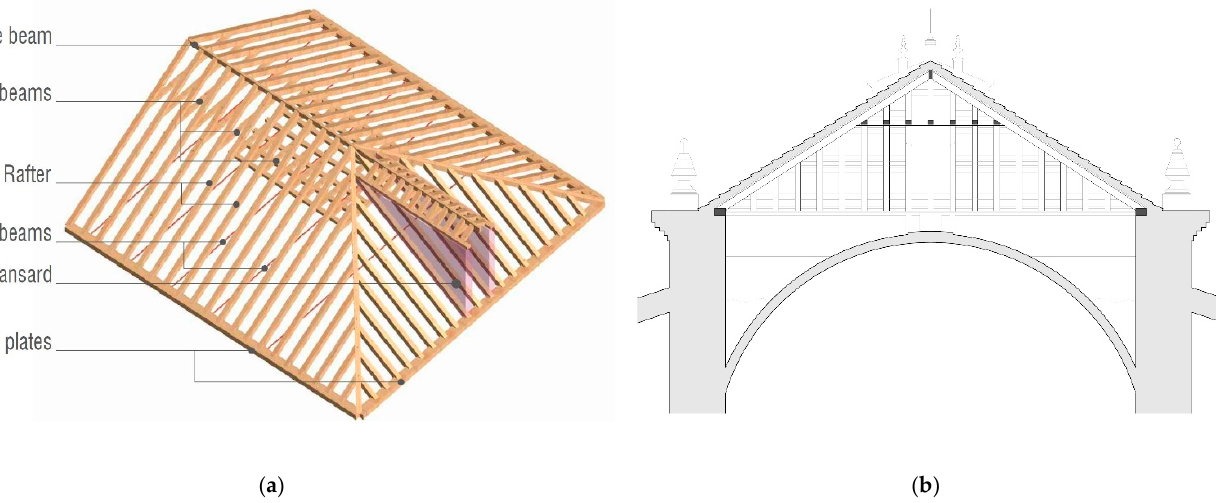
Figure 6. ( a ) Structural diagram and glossary of specific timber terms; ( b ) section on the roof and the timber frame over the brick vault.